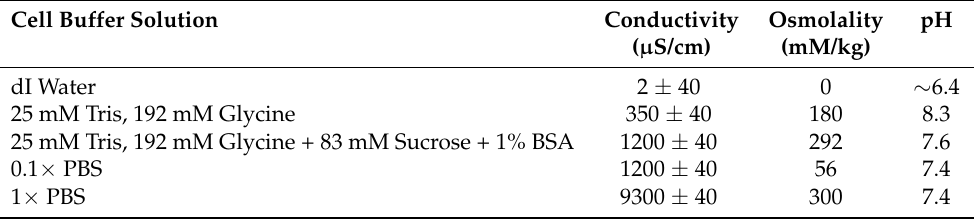
Table 1. Properties of cell buffers important to cell viability maintenance and sensitive impedance detection.